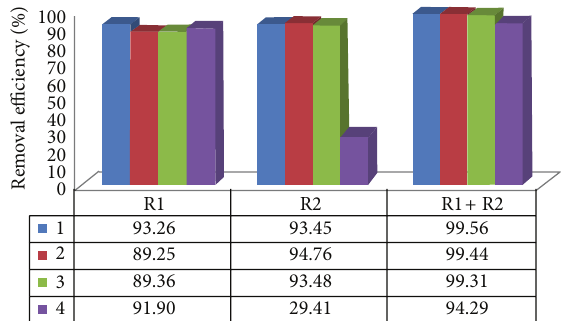
Figure 6: Removal efficiency of thermotolerant coliforms in treat- ment system II, consisting of UASB reactor, anaerobic filter (AF), trickling filter (TF) and decanter (D) placed in series, in assays 1, 2, 3, and